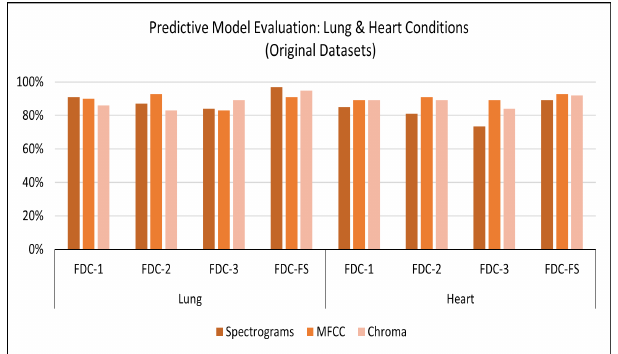
Figure 6. Accuracy for Lung/Heart Condition Detection (Original